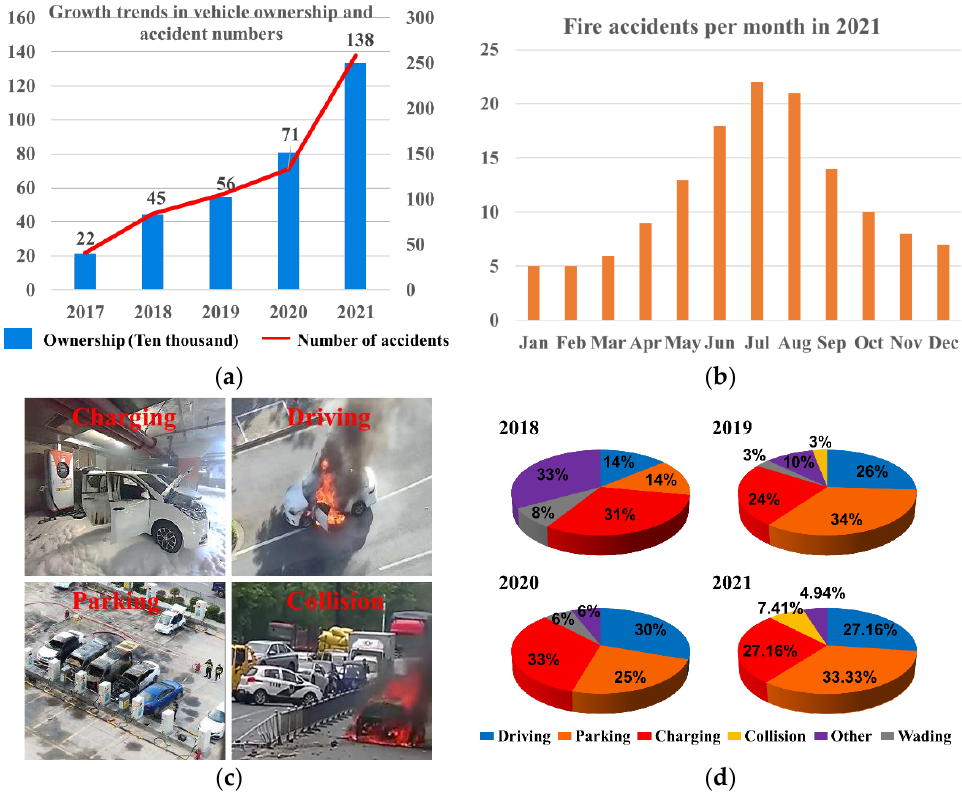
Figure 4. Investigation of EV fire accidents: ( a ) the number of EVs and fire accidents, with incomplete statistics; ( b ) the number of fire accidents per month in 2021; ( c ) fire accident photos; ( d ) the vehicle status at the time of the fire accident.